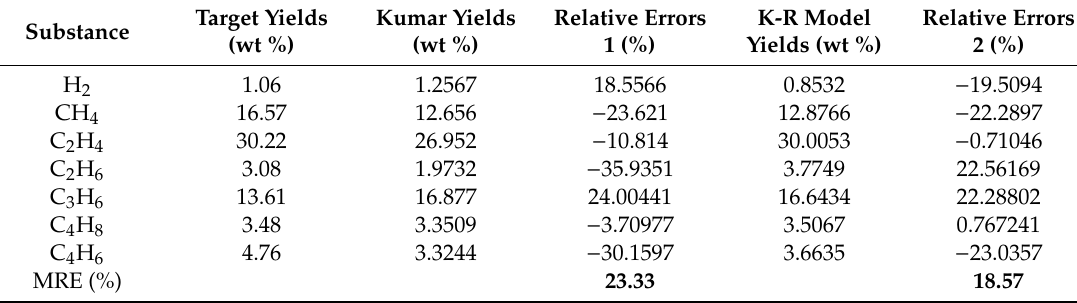
Table 9. Compared Result between the Kumar and K-R models with naphtha (1). Table 10. Compared Result between the Kumar and K-R models with naphtha